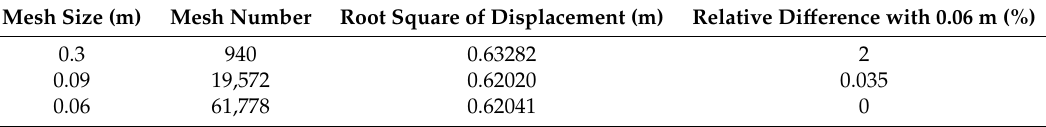
Table 5. The convergence test for TLD mesh selection.